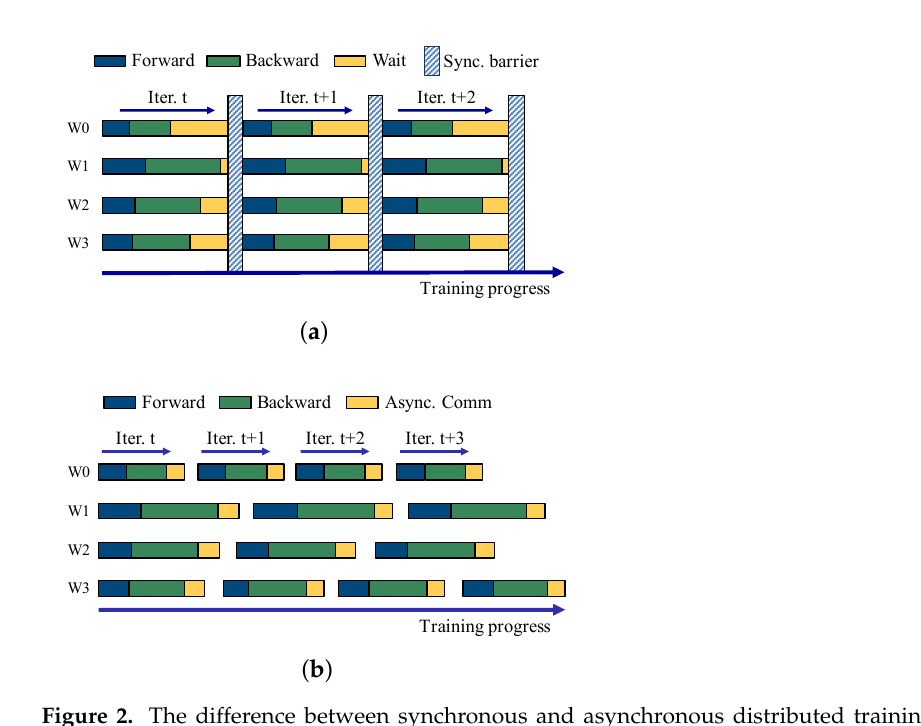
Figure 2. The difference between synchronous and asynchronous distributed training; ( a ) syn- chronous distributed training; ( b ) asynchronous distributed